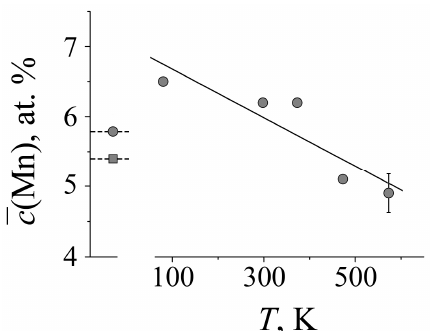
Figure 4. Spectra for the alloy Fe 93.2 Mn 6.8 . Treatment (state): ( a ) annealed at 1073 K (as-received), ( b ) annealed at 773 K, 1 h (aged); ( c ) as-received and HPT at 80 K; ( d ) as-received and HPT at 573 K.